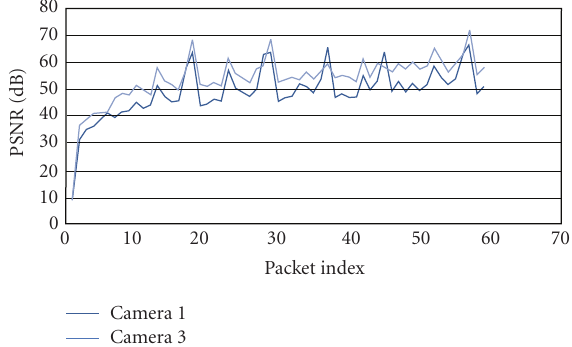
Figure 15: Breakdance : loss of a single packet of depth information.